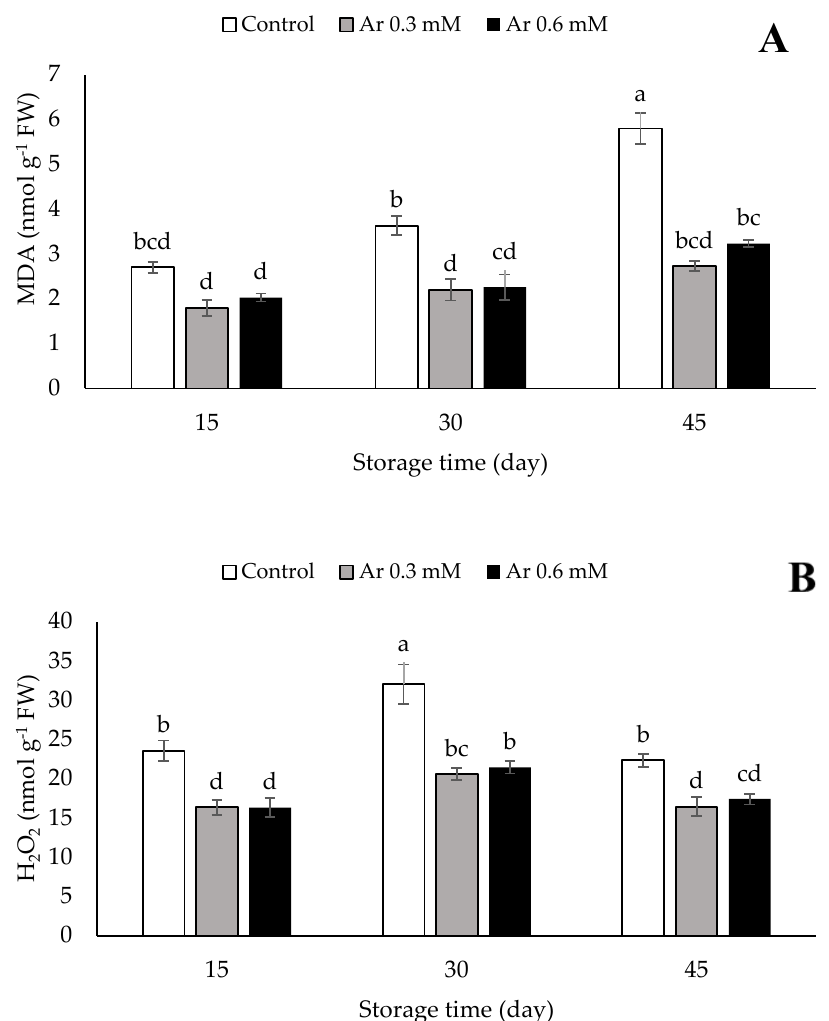
Figure 2. The effect of different levels of postharvest treatment of L-arginine on the MDA ( A ) and H 2 O 2 ( B ) of persimmon cv. “Karaj” fruits during cold storage (DMRT, p ≤ 0.05). The values of data are average of n = 3, and bar represents standard error of the means. Different letters above the bars show significant difference at p < 0.05 by Duncan’s multiple range test.